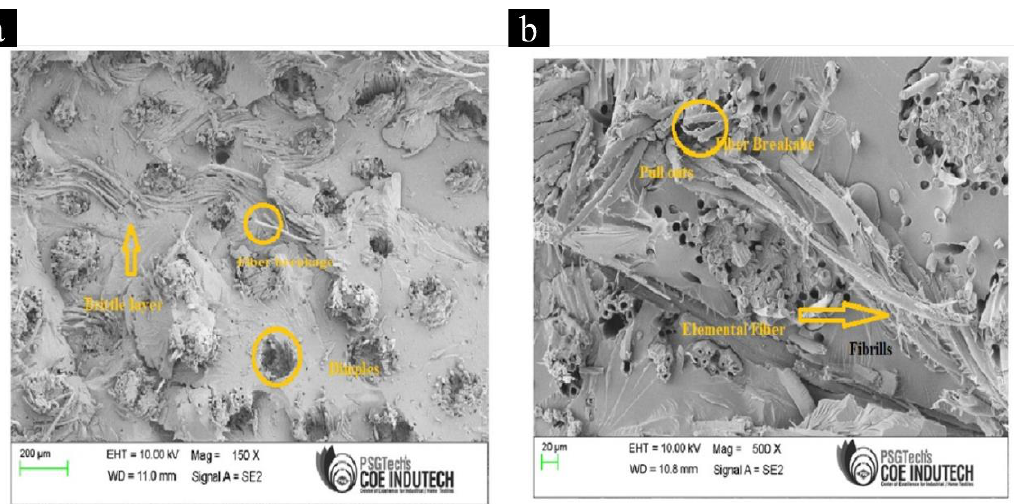
Figure 7. SEM images of ( a ) laminate 1: Bamboo + Epoxy and ( b ) laminate 6: Kenaf + Bamboo + MWCNT + Epoxy.